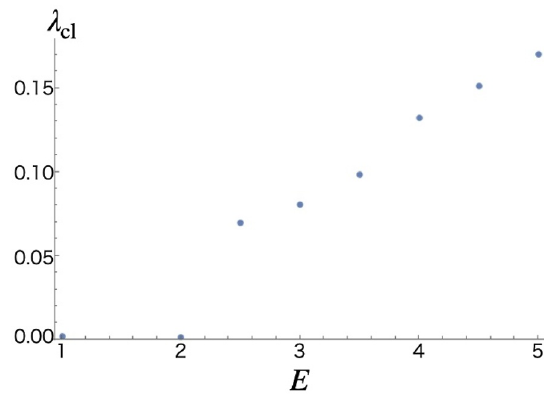
Figure 2 . The classical Lyapunov exponents of our CHO Hamiltonian system (1.1) as a function of the energy of the initial condition. Note that we randomly chose the initial conditions for the numerical calculation of the Lyapunov exponents, and did not evaluate the maximum value of them for a given energy. This (cid:12)gure is for a rough understanding of the classical behavior of chaos of our system, and for the estimation of the value of the Lyapunov